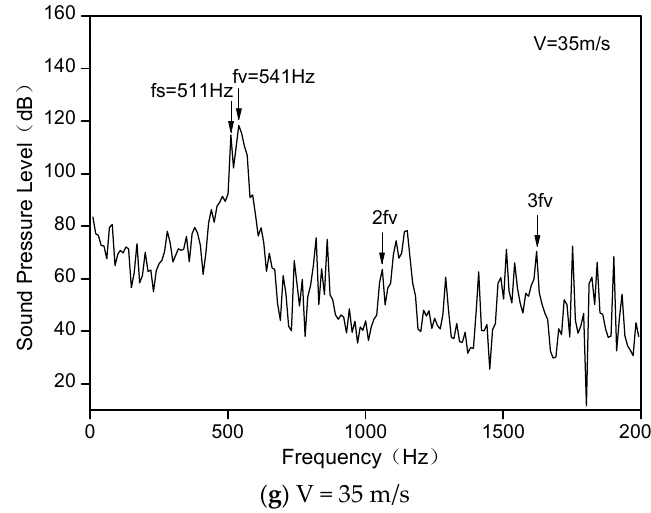
Appl. Sci. 2022 , 12 , x FOR PEER REVIEW Figure 13. Sound pressure spectrum in the pip under different flow velocities. Figure 13. Sound pressure spectrum in the pip under different flow velocities.